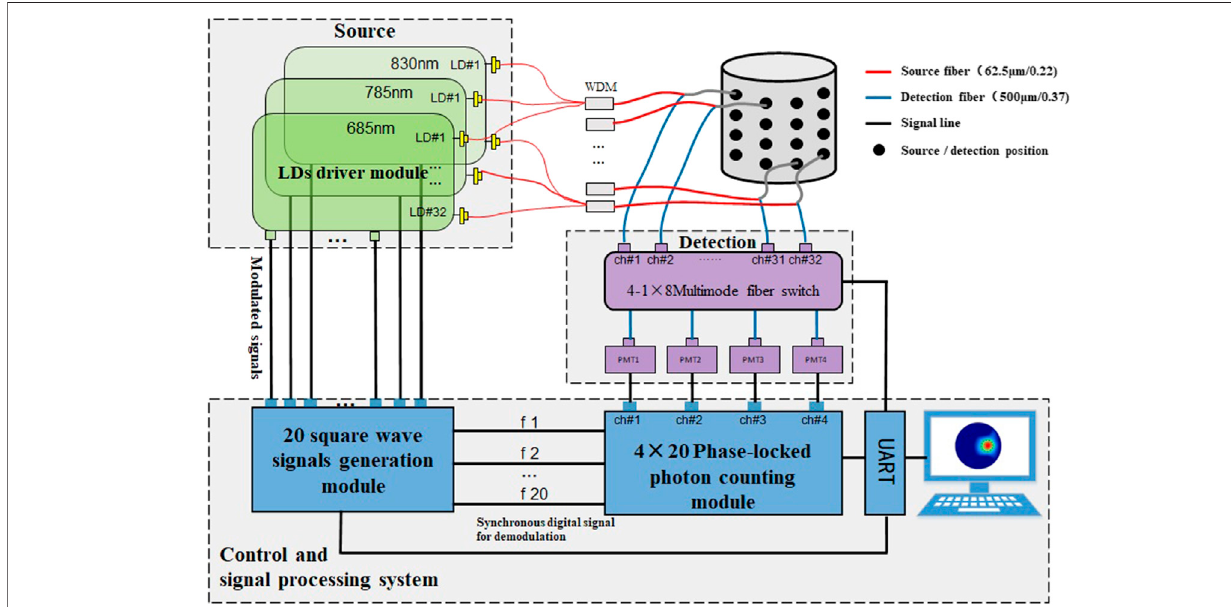
FIGURE 1 | Schematic of the CW dynamic diffuse optical tomography system.